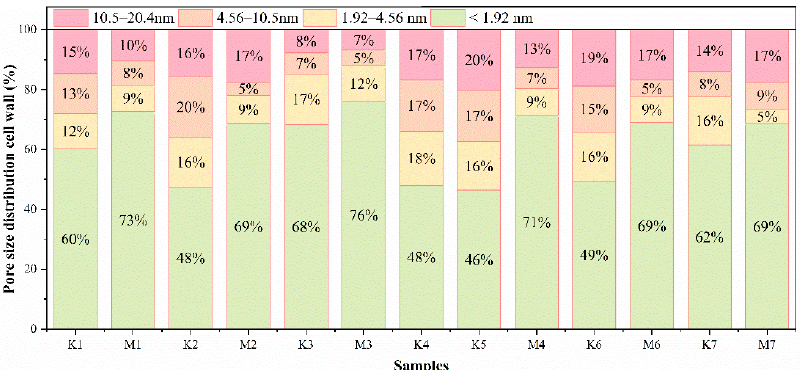
Figure 12. The pore size distributions of the cell wall in waterlogged archaeological wood (A1–6) and modern wood (M1–6). Note: the values in the figure are the average values of three experimental tests and calculations.